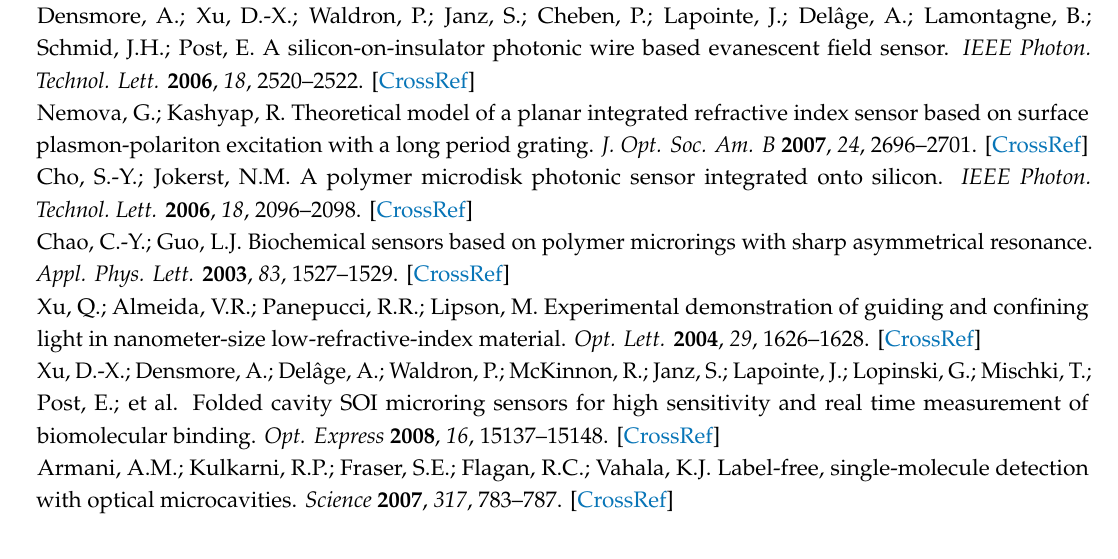
Figure 4. The calculated spectral responses of an MZI sensor when choosing ε/λ 0 = 0.001 μm −1 .